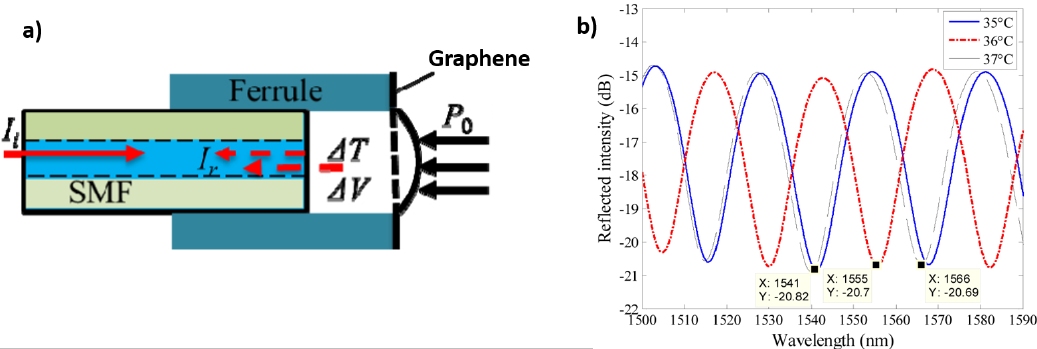
Figure 5. ( a ) Schematic diagram of the FP sensor; ( b ) Reflection spectra of the FP sensor for different temperatures. Reprinted with permission from [73].